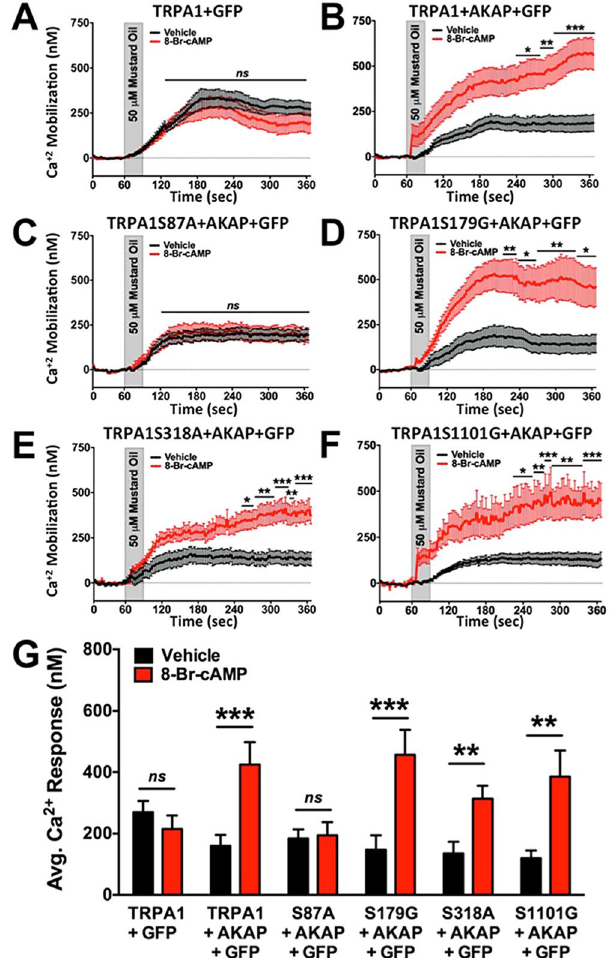
Figure 5. Site-Directed Mutagenesis of Potential PKA phosphorylation sites on TRPA1. Cumulative traces from Chinese hamster ovary (CHO) cells transiently transfected with various cDNAs in the following combinations: ( A ) TRPA1 and empty green fluorescence protein vector (GFP), ( B ) TRPA1, AKAP and GFP, ( C ) TRPA1 S87A, AKAP and GFP, ( D ) TRPA1 S179G, AKAP and GFP, ( E ) TRPA1 S318A, AKAP and GFP, or ( F ) TRPA1 S1101G, AKAP and GFP. Real-time Ca 2 + accumulation measurements were recorded from GFP- positive cells following vehicle (black) or 8-Br-cAMP (10 μ M, red) pre-treatment (5 min) to a mustard oil (MO, 50 μ M, 30 sec) challenge. *** p < 0.005; ** p < 0.01; * p < 0.05; two-way ANOVA with Bonferroni post-hoc analysis. G . Quantified results from cumulative recordings (n = 12–46); ns = no significance; *** p < 0.005; ** p < 0.01; trace significance determined by two-way ANOVA with Bonferroni posthoc analysis and quantified data significance determined by unpaired student’s t